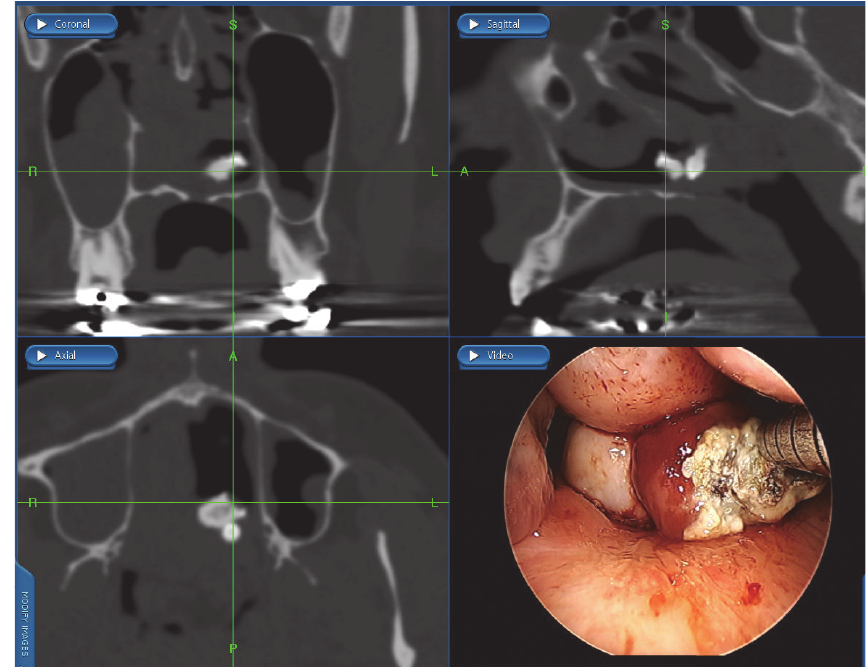
Figure 4: Use of intraoperative CT image guidance assistance during skull base approach. Computer-assisted navigation system (image guidance) highlighting intraoperative CT scan imaging in coronal, sagittal, and axial views. With the registered instrument tip contacting the anterior face of the lesion (endoscopic image at bottom right), the fine cut maxillofacial CT scan shows calcified material present within the skull base teratoma at this site of tumor contact (intersection point of green lines), representing intratumoral dentition.